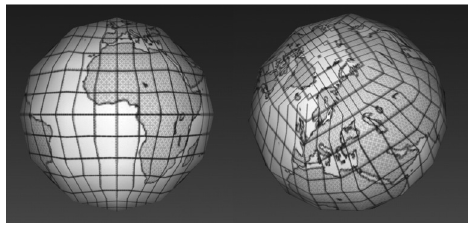
Fig. 27. Virtual regular octahedron with a map of the